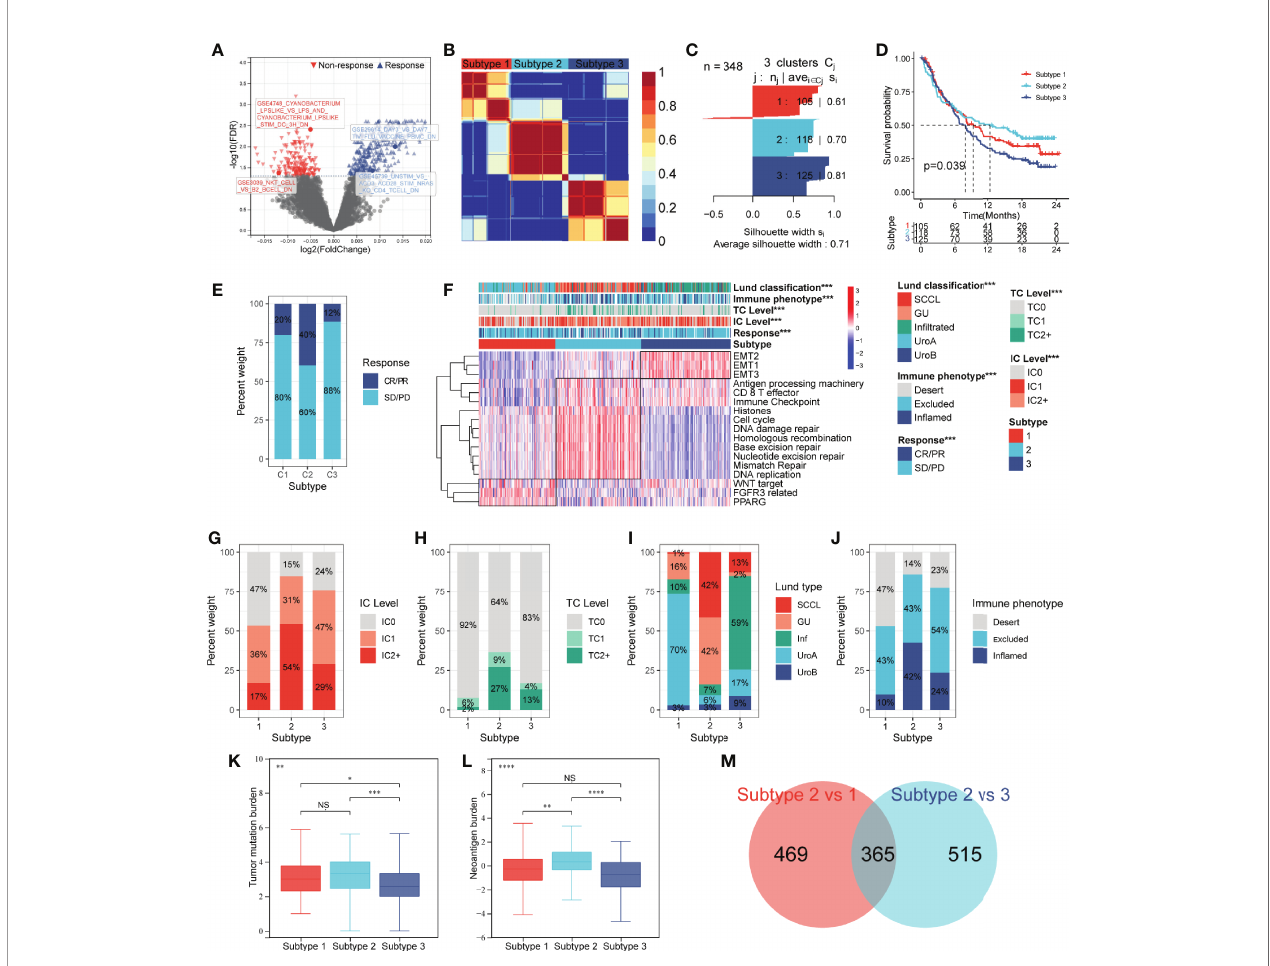
FIGURE 2 | Construction of an IGS-based classi fi cation (IGSC). (A) A volcano plot showed the differentially expressed gene sets between response and non- response groups in IMvigor210 cohort. (B) IMvigor210 cohort was classi fi ed into three subtypes. (C) The silhouette width value for the classi fi cation was 0.71, suggesting a fi ne match between a sample and its identi fi ed subtype. (D) Kaplan – Meier survival analysis showed that Subtype 2 had the best prognosis, Subtype 3 had the worst prognosis, and Subtype 1 had an intermediate prognosis. (E) The response rate to PD-L1 immunotherapy was signi fi cantly higher in Subtype 2 than those in Subtypes 3 and 1. (F) A heatmap showed the correlation between IGSC subtypes and clinical and immune features. (G – J) The proportions of IC levels (IC0, IC1, and IC2+), TC levels (TC0, TC1, and TC2+), Lund classi fi cations (SCCL, GU, inf, UroA, and UroB), and immune phenotypes (in fl amed, excluded, and desert) in different IGSC subtypes. (K, L) Tumor mutational burden and neoantigen burden in different IGSC subtypes. (M) A Venn plot shows the intersected differential gene sets between Subtypes 2 and 1 and between Subtypes 2 and 3. * P < 0.05, ** P < 0.01, *** P < 0.001, **** P < 0.0001; NS, nonsigni fi cant; IGS, immunologic gene sets; PD-L1, programmed cell death-ligand 1; IC, immune cells; TC, tumor cells; Inf, in fi ltrated; SCCL, squamous cell carcinoma-like; UroA, urothelial-like A; UroB, urothelial-like